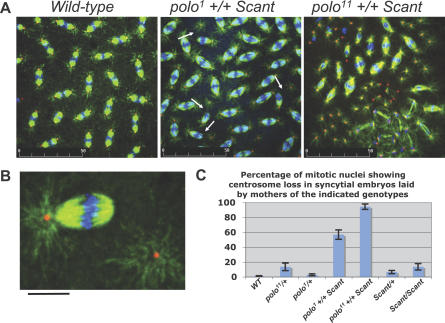

Scant Interacts Genetically with polo, Leading to Mitotic Defects in Embryos(A) Aberrant mitotic figures in embryos derived from females heterozygous for polo and Scant. Embryos were collected for 2–3 h, dechorionated, and fixed for immunofluorescence. Stainings are α-tubulin (green), γ-tubulin (red), and DNA (blue). Representative examples of mitotic phenotypes are shown for the indicated genotypes. Arrows in the center panel indicate the displacement of centrosomes from one pole. Scale bars are in μm.(B) Typical displacement of one centrosome observed in embryos derived from polo1 +/+ Scant heterozygous females. The scale bar represents 10 μm.(C) Quantitation of aberrant mitotic figures observed. Embryos were treated as in (A) and syncytial single embryos with mitotic nuclei were scored for the percentage of defective nuclei (having lost at least one centrosome). Numbers are average percentages (± standard error of the mean).